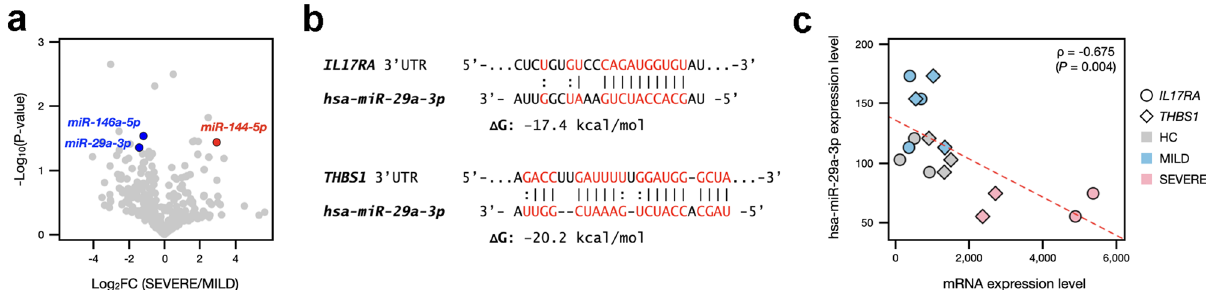
Figure 3. Correlation between the expression levels of hsa-miR-29a-3p and its two putative target genes in the severe COVID-19 samples. ( a ) Volcano plots representing differentially expressed miRNAs with the log2- fold change plotted against the negative log10 p-value of the compared groups. Red and blue dots indicate upregulated and downregulated miRNAs, respectively, in the severe COVID-19 samples. ( b ) Sequence alignments of hsa-miR-29a-3p with human IL17RA or THBS1 mRNA 3 ′ -UTRs. The prediction of binding sites and free energy (ΔG) were obtained from miRWalk 3.0 online prediction software. ( c ) Scatter plots showing the expression levels of hsa-miR-29a-3p versus IL17RA and THBS1 in all eight subjects. ρ indicates Spearman’s correlation coefficient.